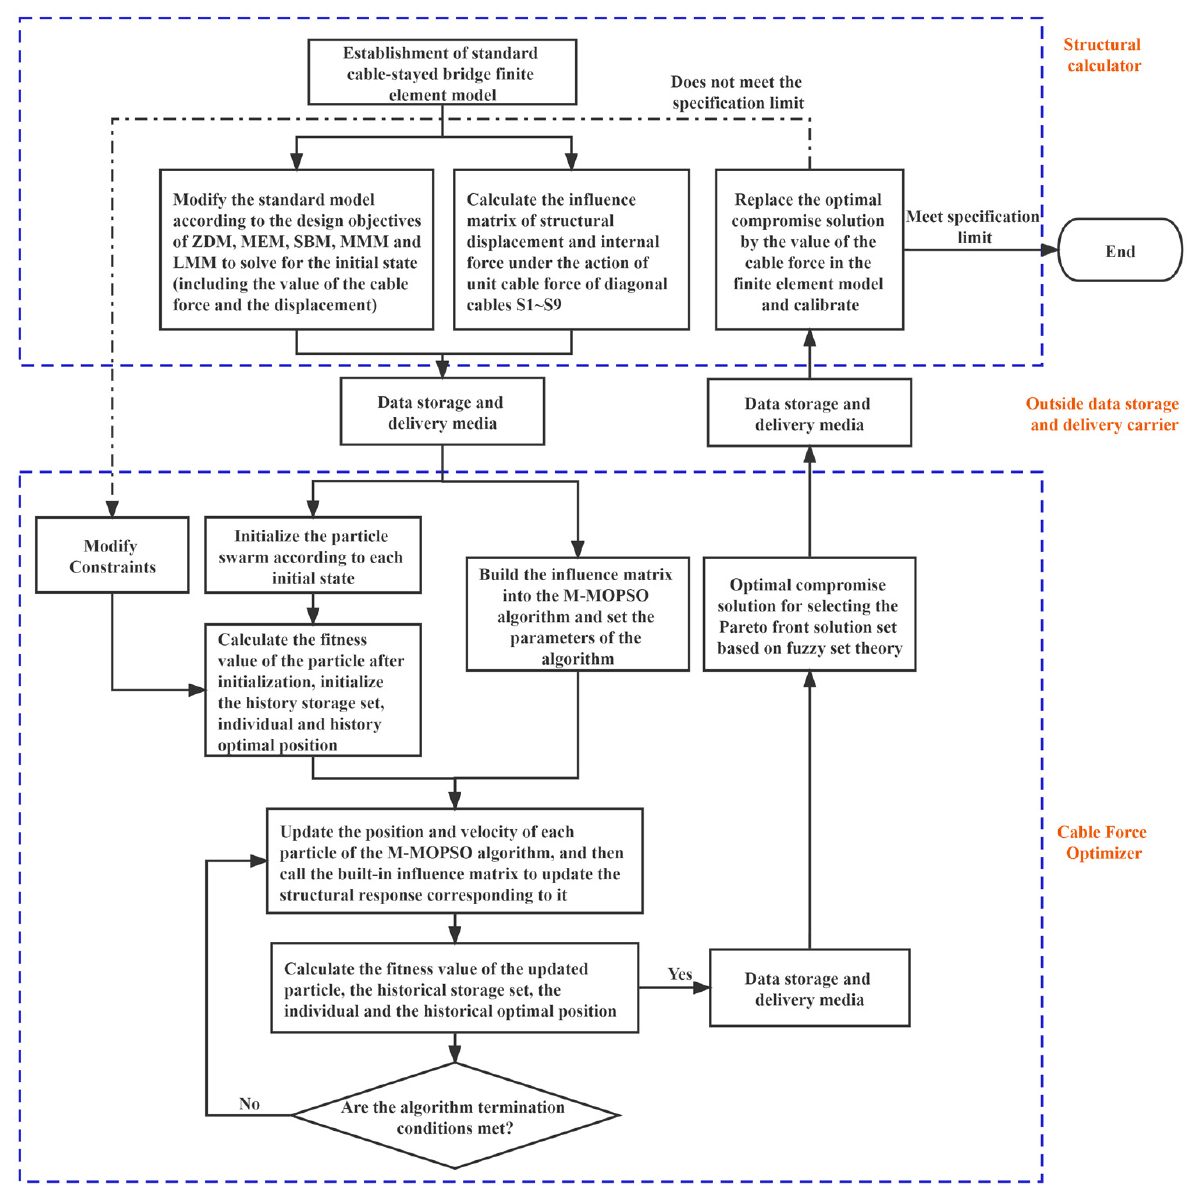
Figure 5. Flow chart of cable force optimization of SOM.